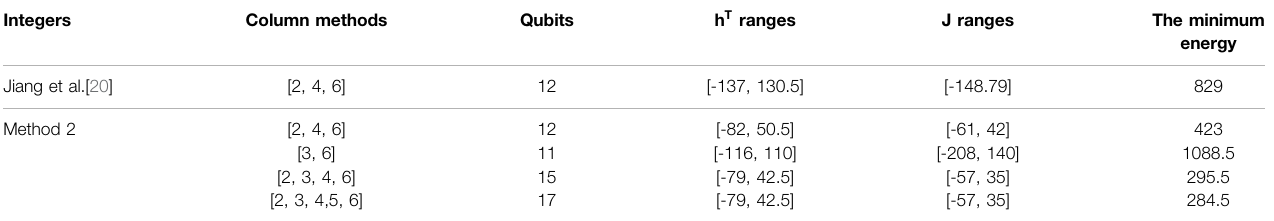
TABLE 5 | Comparison of different methods of factoring the integer 143.